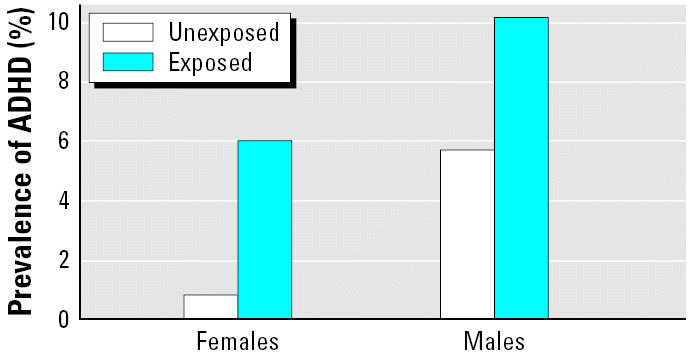
AOR for ADHD among U.S. children by prenatal ETS exposure and sex. The risk for ADHD among ETS-exposed children was greater in females; females who were prenatally exposed to tobacco were at 4.6-fold higher risk for ADHD compared with unexposed females (OR = 4.6; 95% CI, 1.7–12.4), whereas exposed males were at 2-fold higher risk for ADHD compared with unexposed males (OR = 2.1; 95% CI, 0.9–4.7) (p = 0.141 for sex by prenatal ETS exposure interaction). Model adjusted for race/ethnicity, sex, age, blood lead level, ferritin level, presence of a smoker in the home, preschool attendance, and insurance status.